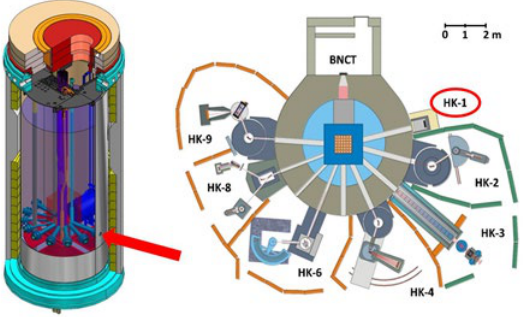
Fig. 1. - (cid:47)(cid:57)(cid:53)-15 reactor (left) and its horizontal channels (right) [1]